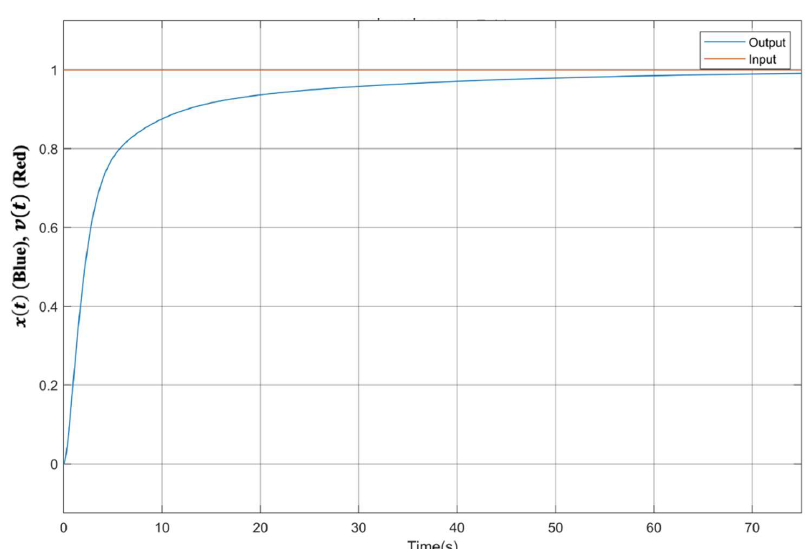
Figure 3. Response to a Step Input with Technique 1.